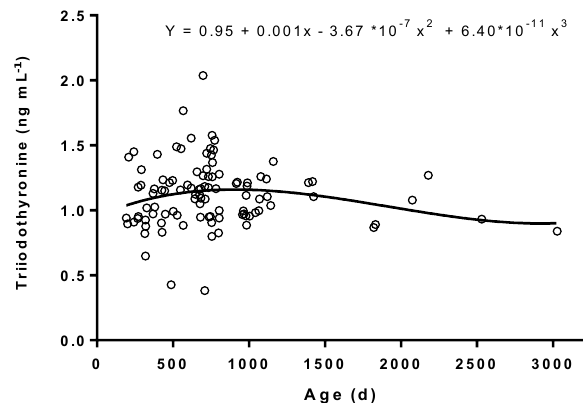
Figure 2. Age-related variations in plasma triiodothyronine con- centrations in male Murrah buffaloes ( n = 103).